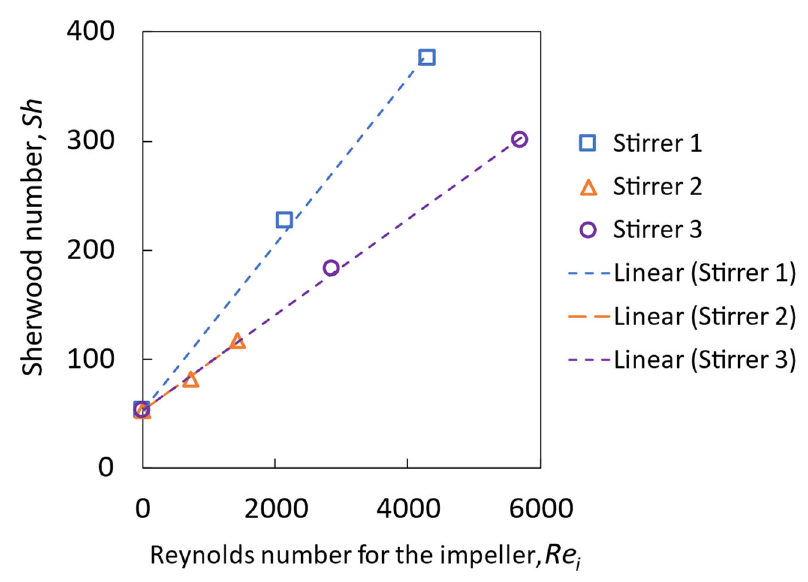
Figure 11. Sherwood number as a function of the impeller Reynolds number derived from the simulation results.